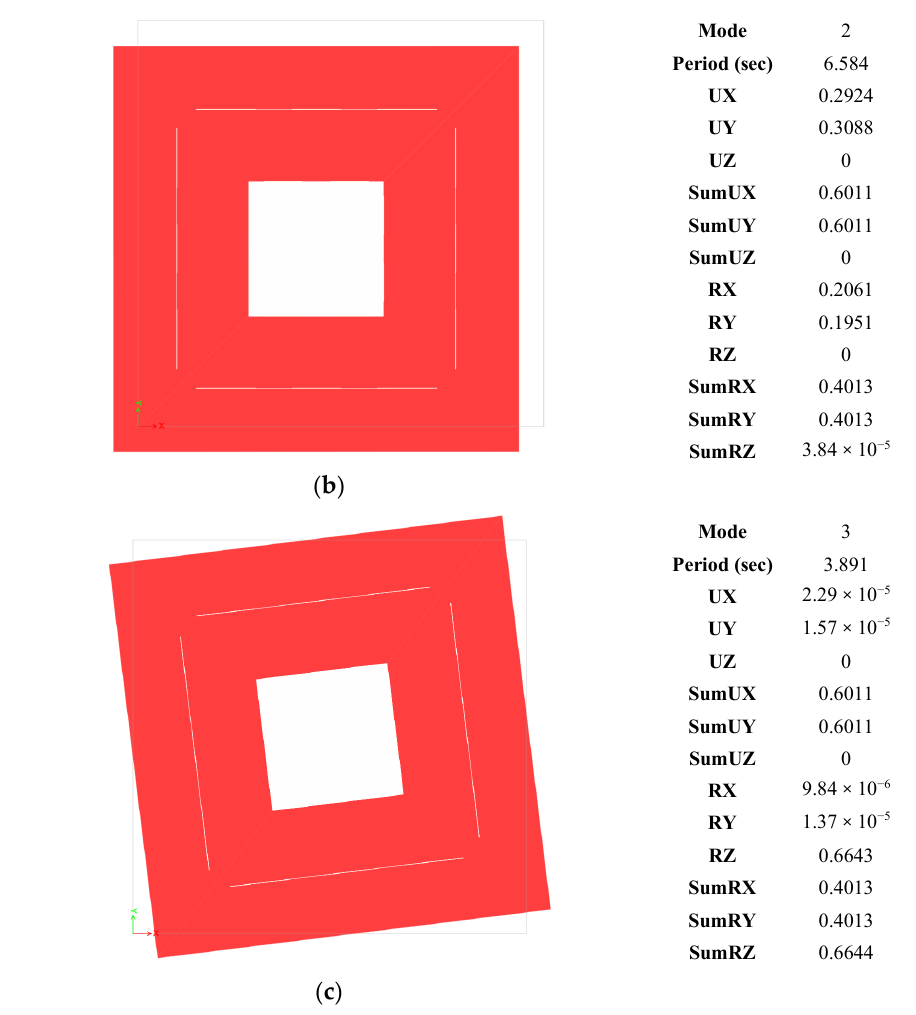
Figure 2. Sample of results for the 60 MPa ETABS model: ( a ) First mode; ( b ) second mode; ( c ) third mode. Table 3. Seismic parameters for base shear